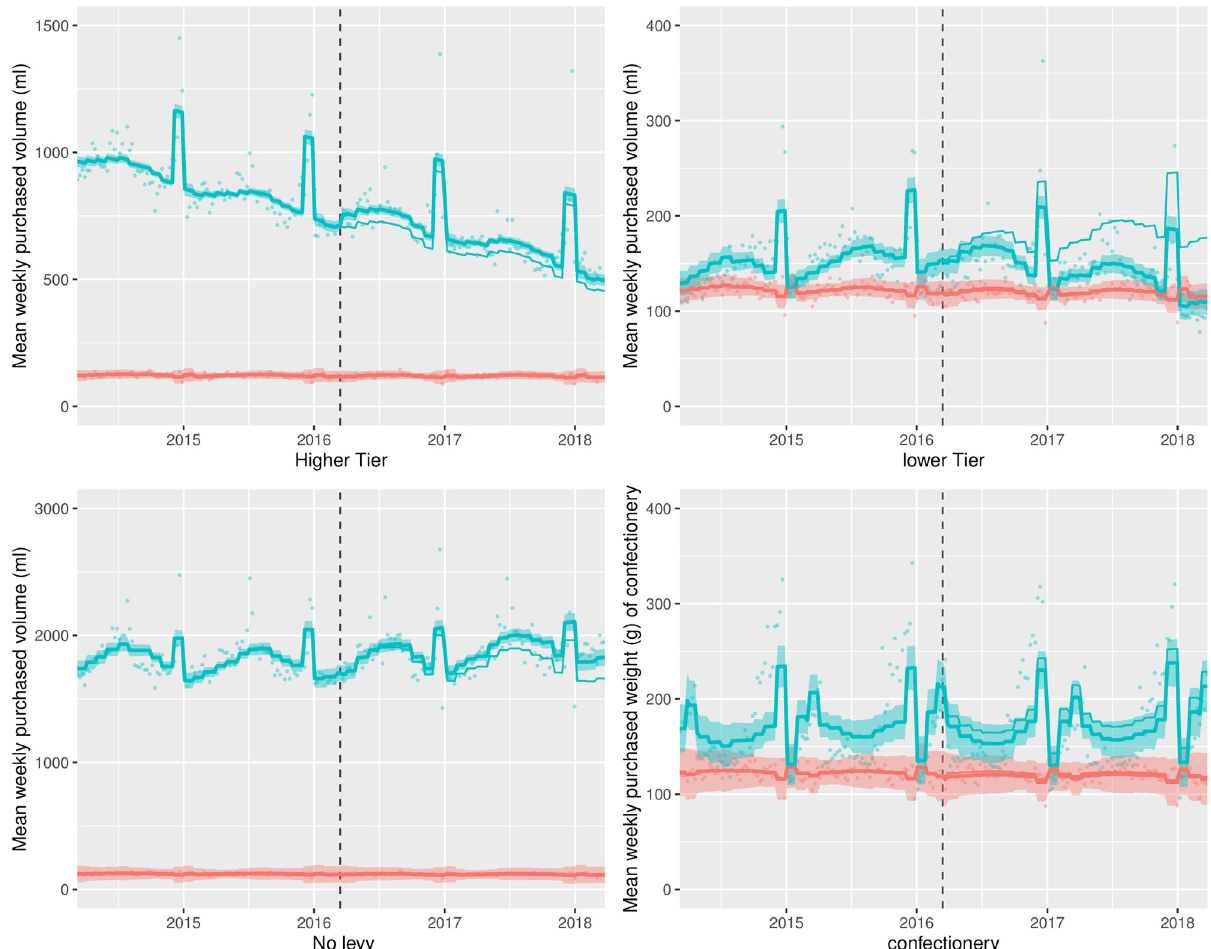
Fig 1. Observed and modelled volume (ml) of drinks liable to the Soft Drinks Industry Levy and weight of confectionery (g) purchased per household per week, March 2014–March 2018. Notes. Points are observed data, thick lines (with shadows) are modelled data (and 95% confidence intervals); thin lines (without shadows) are the counterfactual had the announcement not happened; blue points and lines are drinks/confectionary; red points and lines are the control category of toiletries; the vertical dashed line indicates the point of announcement of the SDIL; Y-axes vary in scale between panels to maximise the resolution of figures; modelled purchases include all adjustments as described in the methods